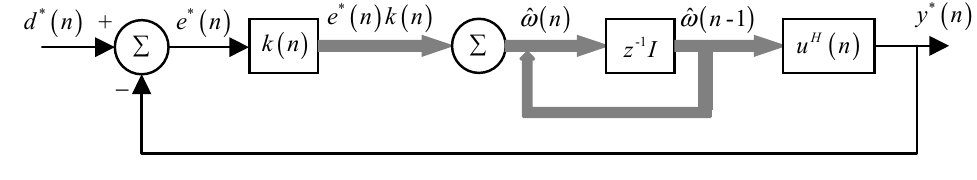
Figure 6. RLS algorithm block diagram.